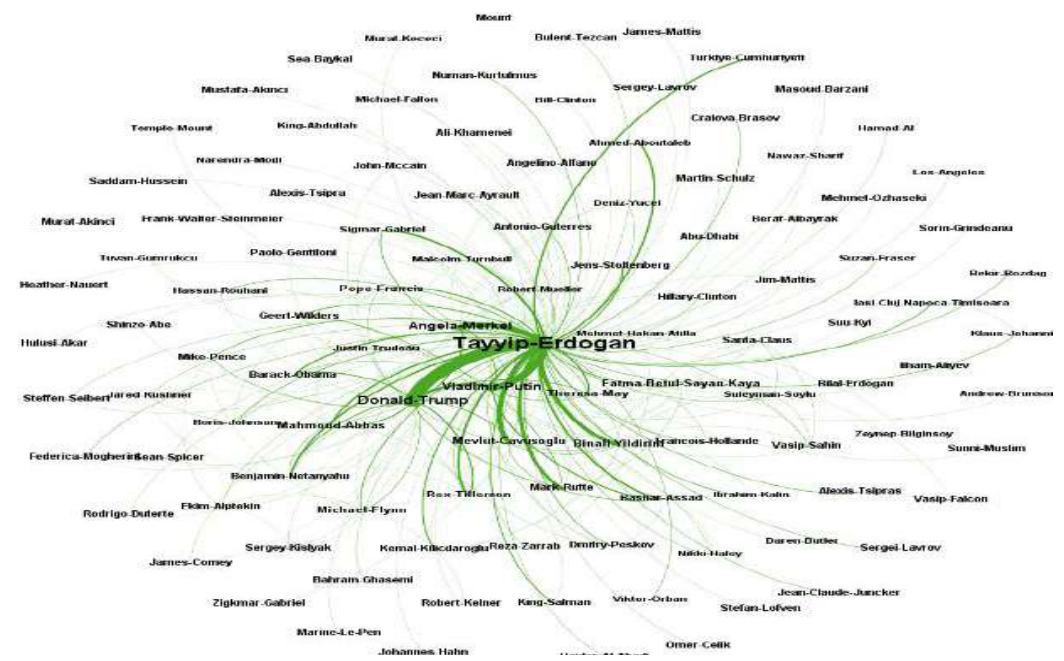
Figure 4: 2017 Network (Source: Authors ‟